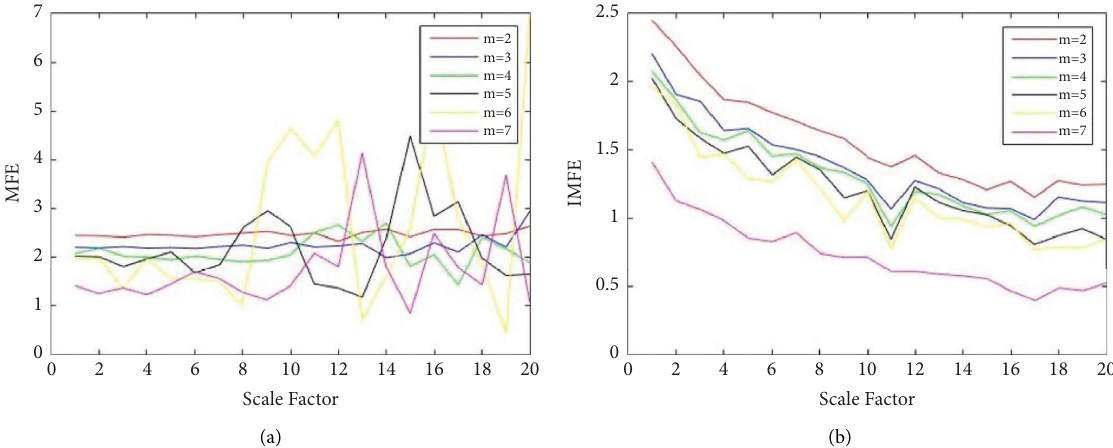
Figure 4: MFE and IMFE of Gaussian white noise with diferent m . (a) MFE of Gaussian white noise with diferent m . (b) IMFE of Gaussian white noise with diferent m .